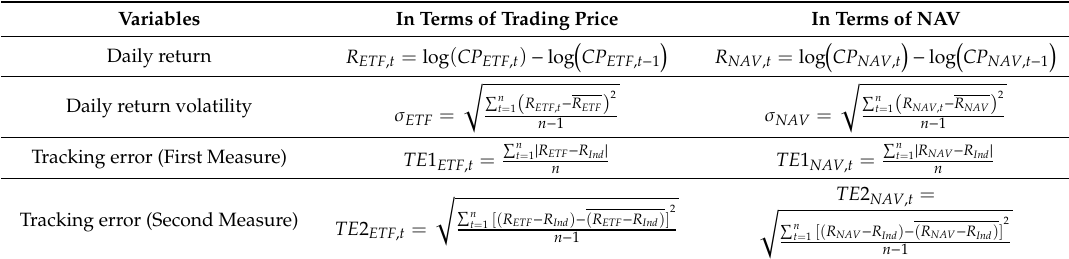
Table A3. Variables Measured in Trading price and NAV.